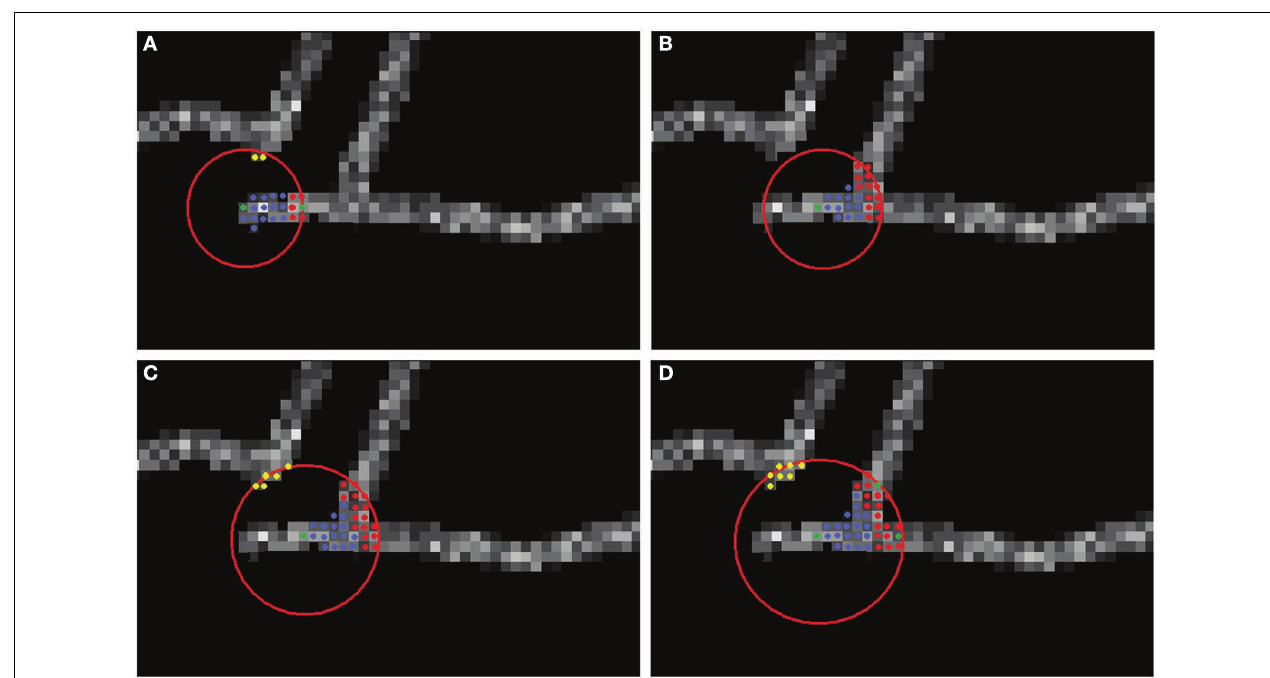
(B) First iteration of scaling. (C) Second iteration of scaling. (D) Last (in this case third) iteration of scaling. Green points from among the candidates (red) are the newly chosen seeds, starting from which each branch will be